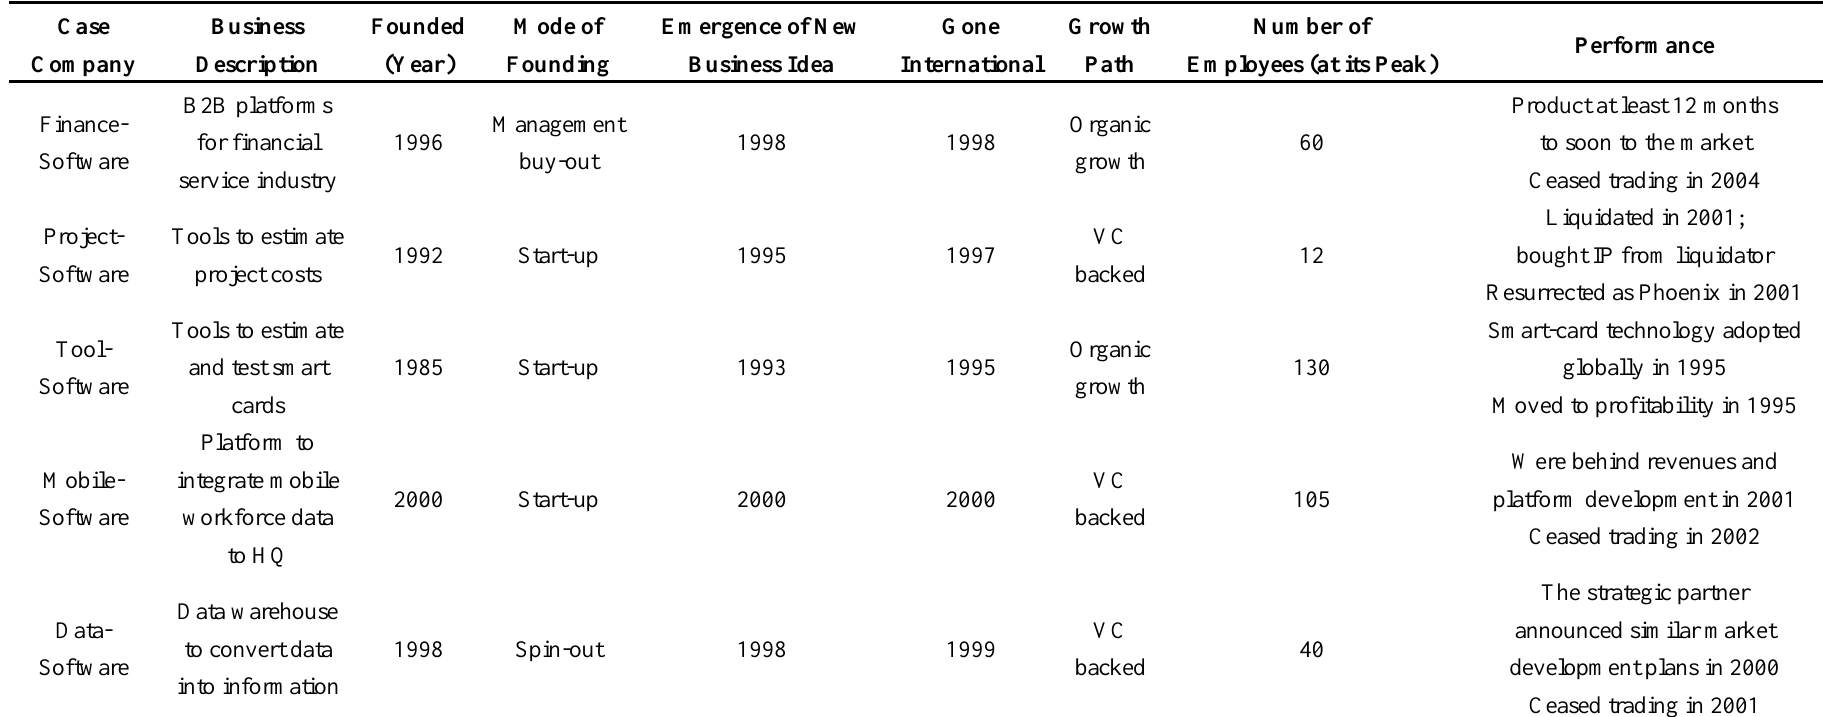
Table 1. Summary of case